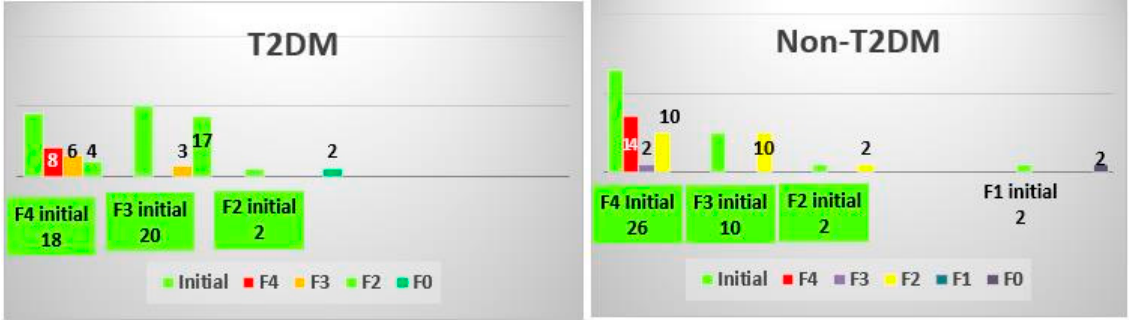
Figure 2. Changes in the FibroTest class after treatment in the T2DM and non-TDM2 groups.